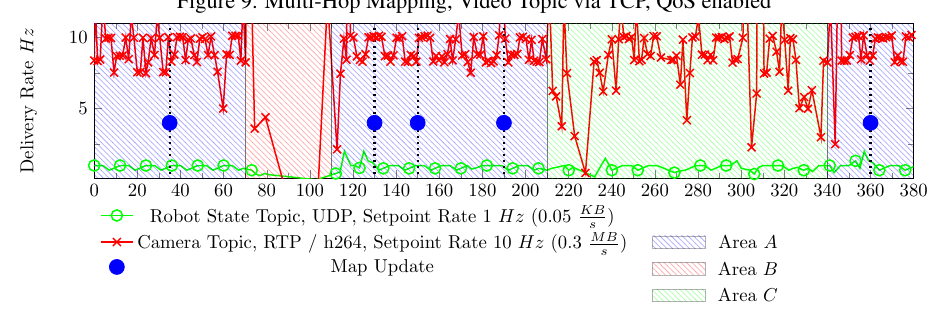
Figure 10. Multi-Hop Mapping, Video h.264 Stream, QoS enabled